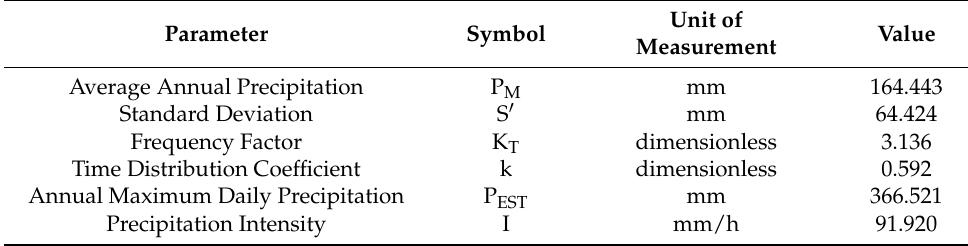
Table 4. Surface drainage coefficient adopted (Source: [30]). Urban Areas Land Occupation